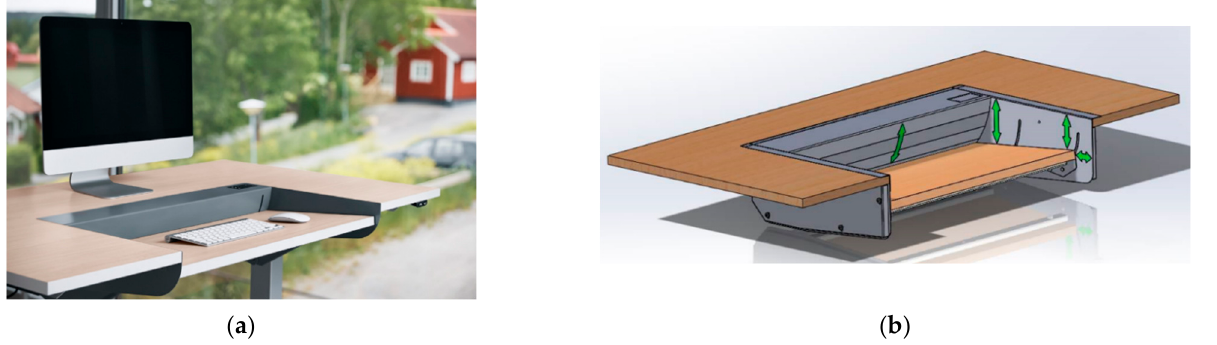
Figure 1. ( a ). An illustration of the dynamic desk DynaDesk. ( b ). Schematic pattern which demonstrates the three movements as executed by DynaDesk: Forward-backward, down-up and forward tilting.